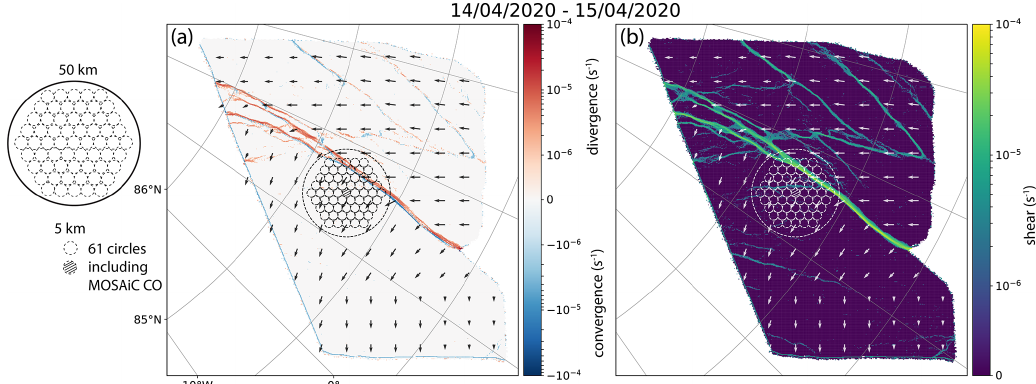
Figure 3. To compare deformation in the vicinity of the ship (5km) with deformation on larger scales (50km), averages were computed for 61 5km circles arranged within a radius of 50km around the ship. Example of divergence, convergence (a) and shear (b) derived from two consecutive Sentinel-1 SAR images acquired on 14 April (07:26:14UTC) and 15 (08:07:03UTC) 2020. Sea ice motion is displayed as black arrows. The image pair shows the strongest deformation event observed. Within 24h, a 2.5km wide north–south-oriented lead opened up ∼ 25km away from the